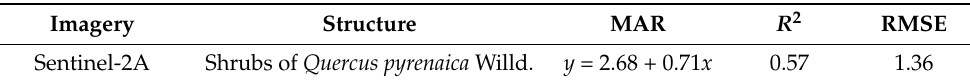
Table 3. Statistics of the performance of a Gaussian process depending on the satellite imagery and story segmentation. MAR: major axis regression fit; R 2 : coefficient of determination; RMSE: root-mean-square error. Imagery Structure MAR Sentinel-2A